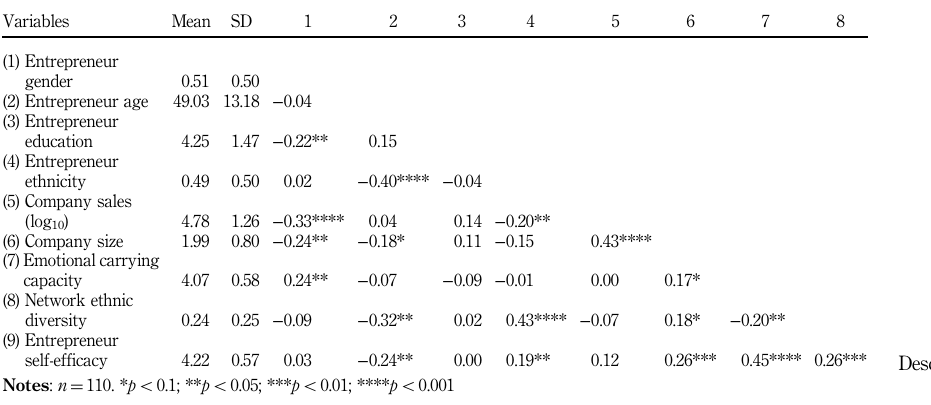
Table IV. Descriptive statistics and